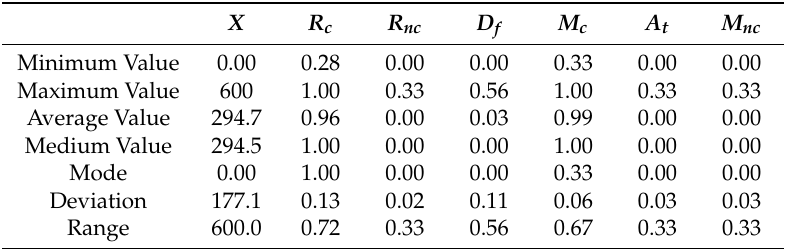
Table 4. Statistical analyses of strategies R c , R nc , D f , M c , A t , and M nc